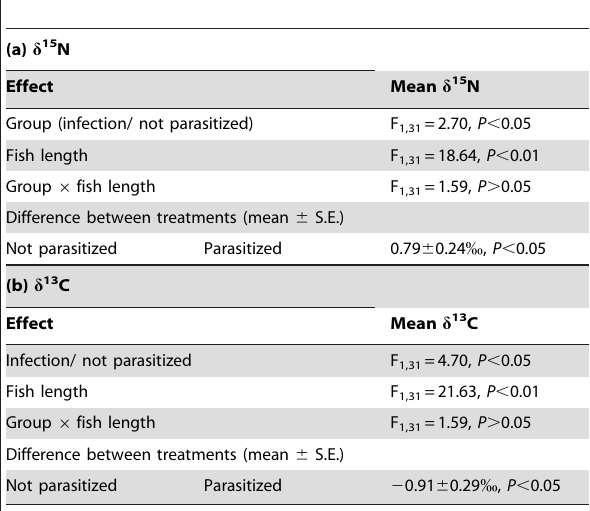
Table 2. Stable isotope analysis of Cyprinus carpio parasitized by Bothriocephalus acheilognathi